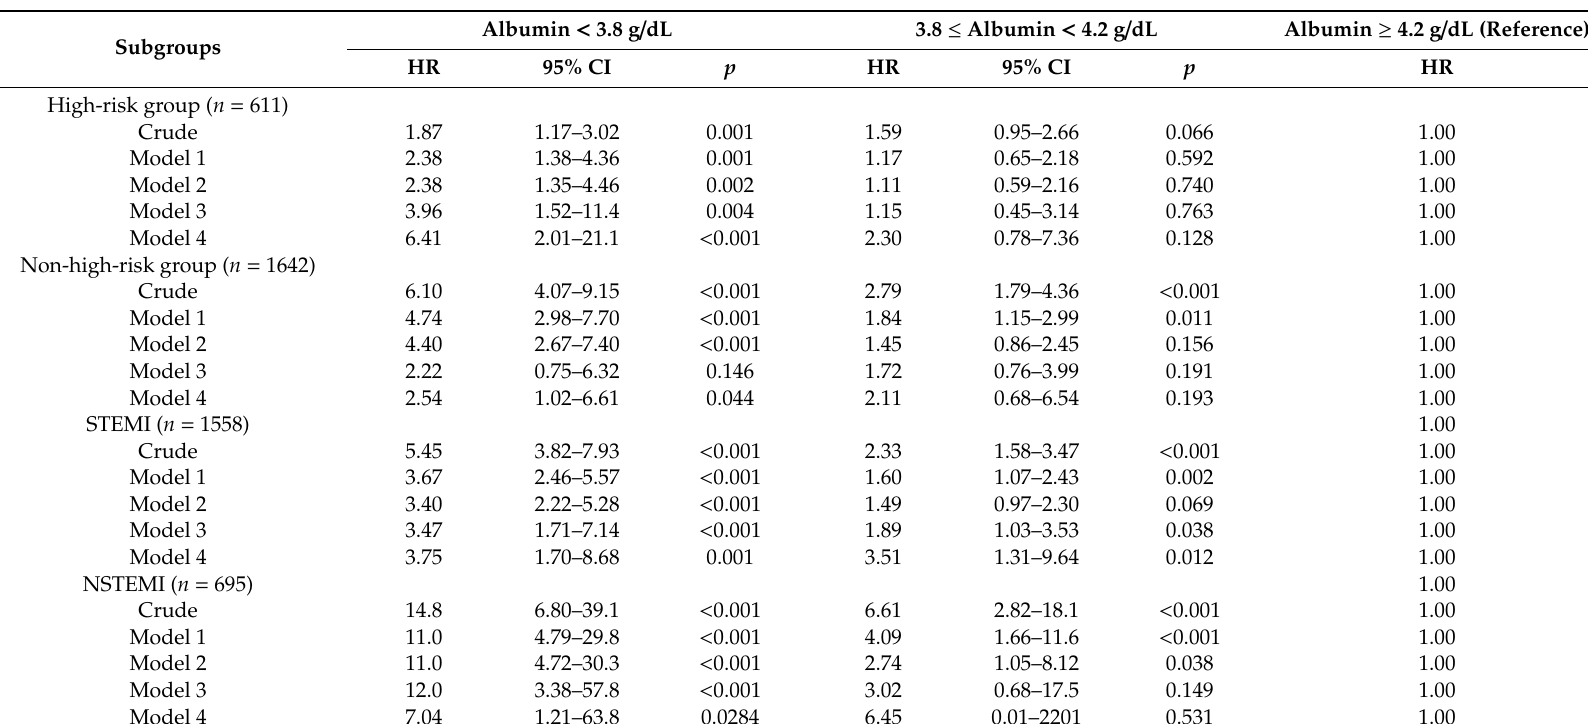
Table 3. Cox proportional hazards analysis for primary composite outcome in subgroups according to the clinical severity (high-risk or non-high-risk) of AMI and subtype of AMI (STEMI or